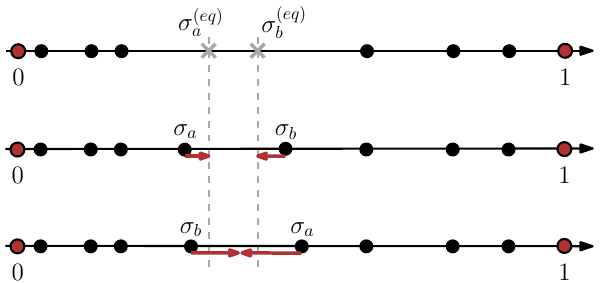
Figure 4 . Determining which solution becomes degenerate. Top: equilibrium positions that the particles try to reach. Middle: in the case (cid:27) a < (cid:27) b the particles converge to distinct locations. Bottom: in the case (cid:27) b < (cid:27) a the particles pinch at a common location creating a degenerate solution. respectively [43], which are the collinear limits. Secondly, the n 3 real roots are guaranteed (cid:0) to lie in the open interval [ 1 ; 1] [43], precisely between the two (cid:12)xed particles, (cid:27) A and (cid:27) B . (cid:0) Lastly, di(cid:11)erent solutions of the scattering equations naturally arise from the permutations of the roots of the Jacobi